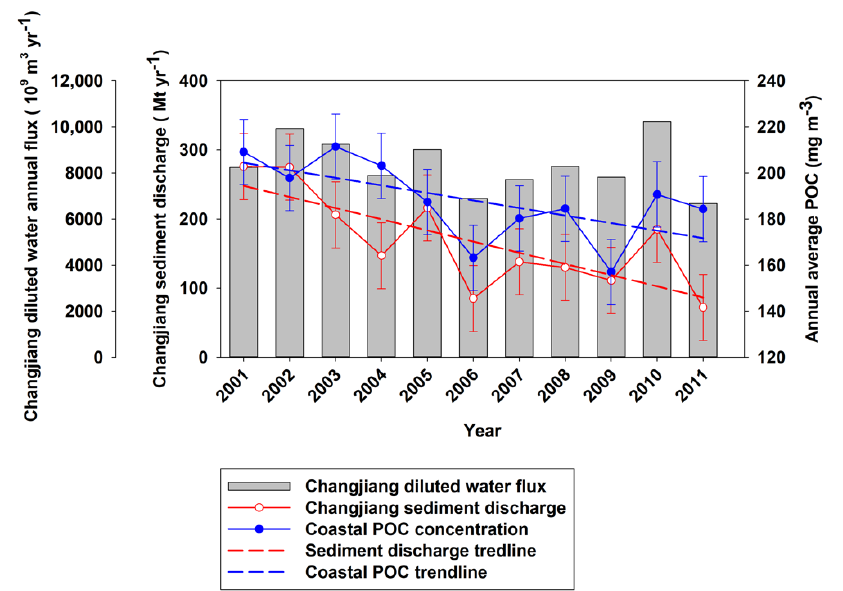
Figure 6. Annual water flux (vertical bars) and sediment discharge (red broken line) from the Changjiang River and POC concentration in the ECS (blue broken line), from 2001 to 2011, respectively. Data was obtained from River Sediment Bulletin of China, 2001–2011, from Datong hydrological station. Trendlines were calculated by linear regression.